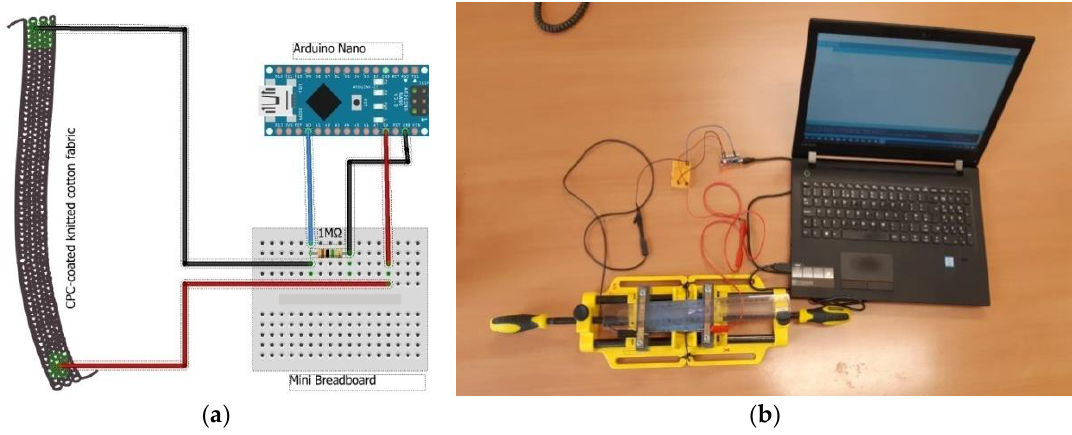
Figure 6. ( a ) Arduino Nano electronic circuitry design; ( b ) resistance measurements